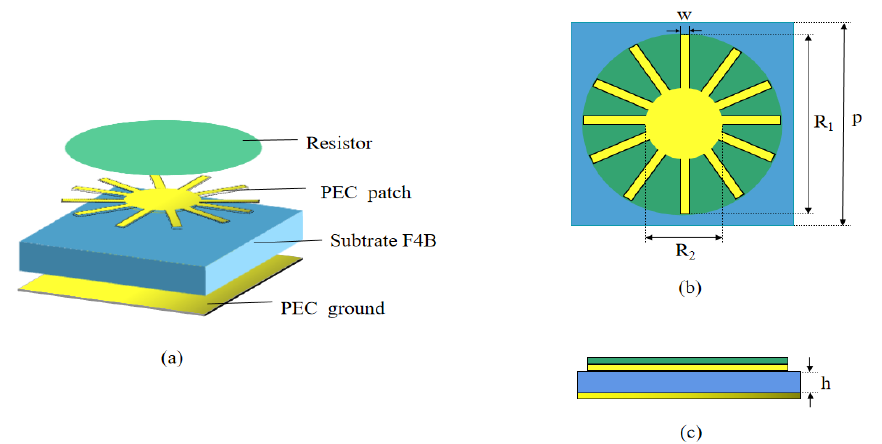
Figure 2. Resistive film periodic unit: ( a ) schematic structure; ( b ) top view; ( c ) side view (p = 5, w = 0.15, R 1 = 2.3, R 2 = 0.4, h = 0.5, unit: mm).